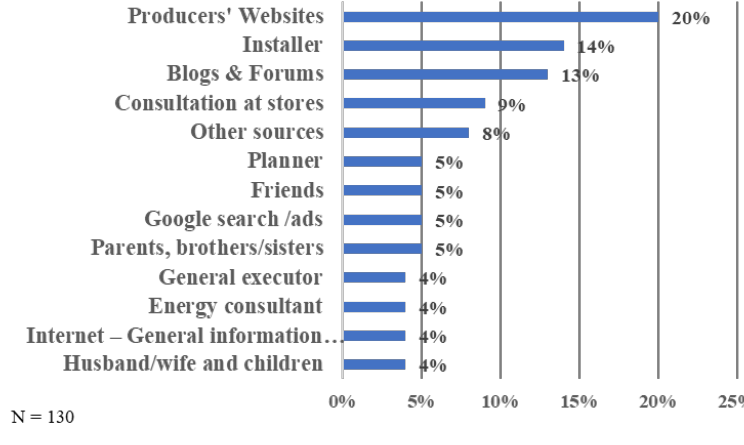
Figure 10. Final decision.